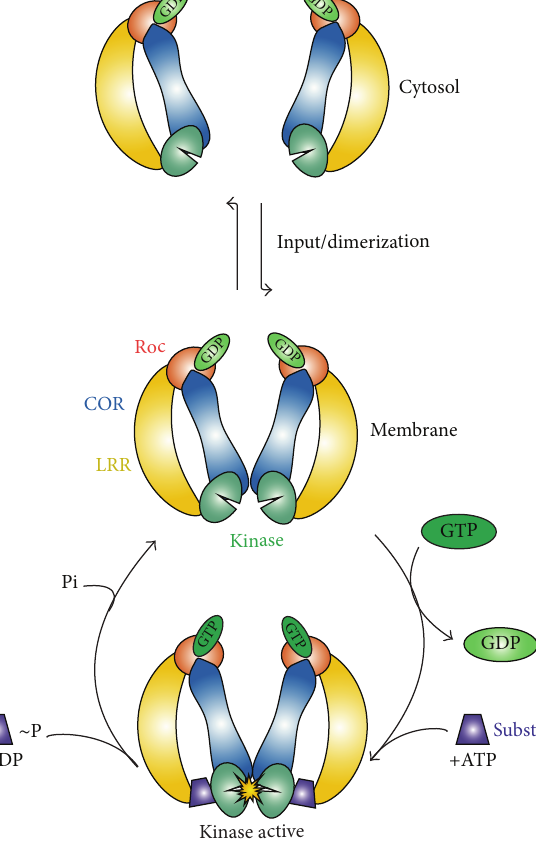
Figure 2: Proposed model of the activation mechanism of LRRK2. LRRK2activationisatleastregulatedbythreedifferentmechanisms: cycling between (1) an almost inactive monomer and active dimer at the membrane, (2) intramolecular activation, and (3) binding of input/substrate to the N- and C-terminal